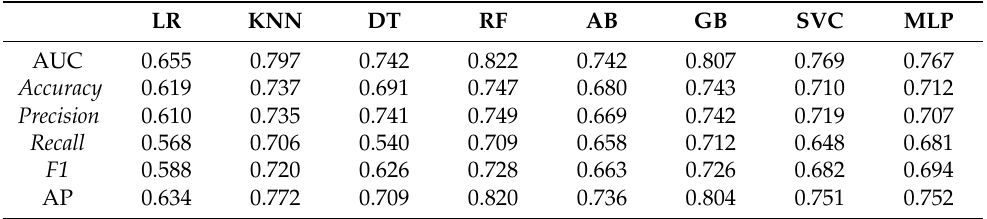
Table 1. Summary of the scores obtained on the test dataset with the different classification algorithms to detect observations higher than the median. Precision and Recall were obtained for a threshold of 0.5.